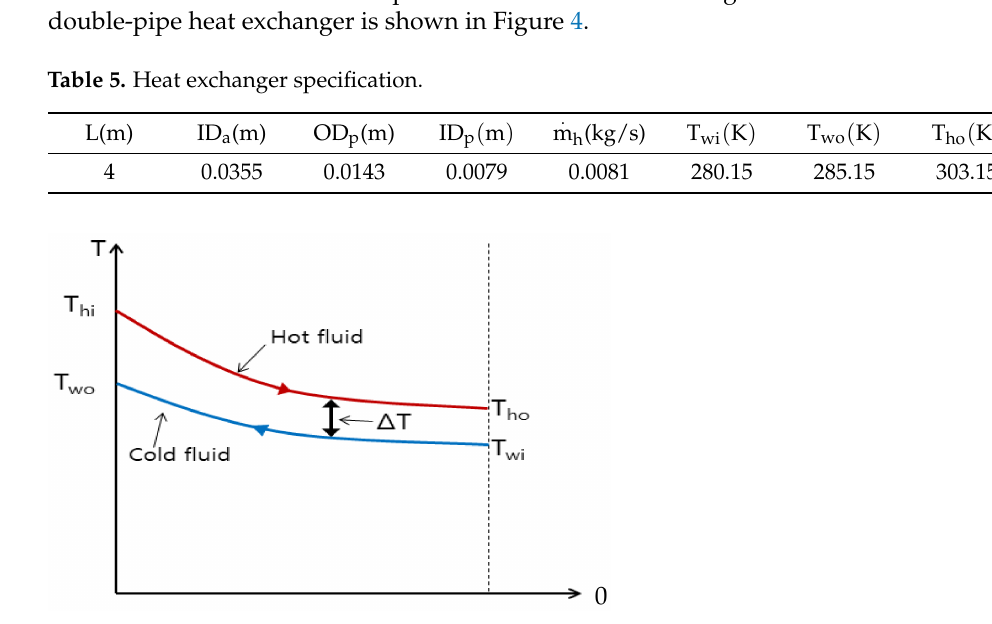
Figure 4. Temperature distributions for a counter-flow heat